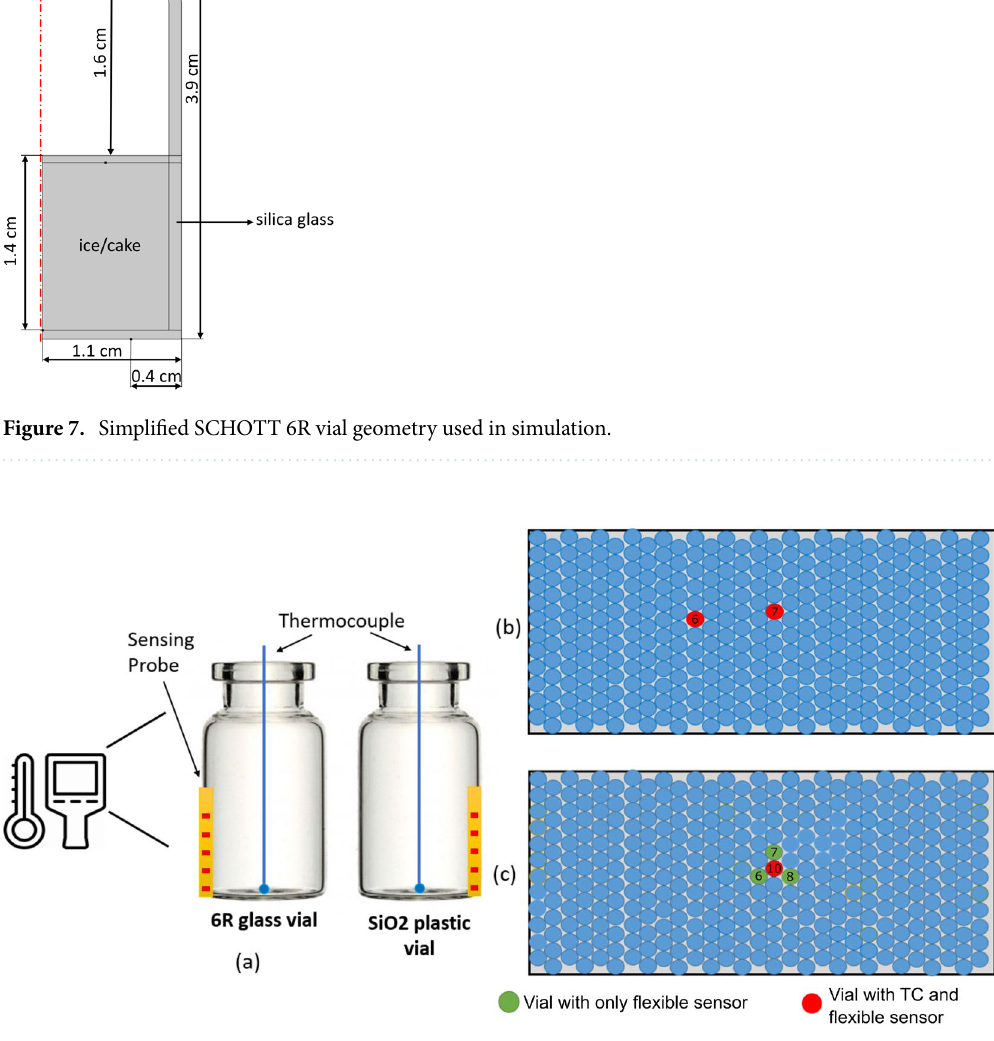
Figure 8. Experimental setups: ( a ) two isolated vials (glass and plastic) with a thermal camera ( b ) 2 center vials equipped with flexible sensors placed in the center of a full tray. ( c ) Experimental set-up for testing the thermocouple heating.